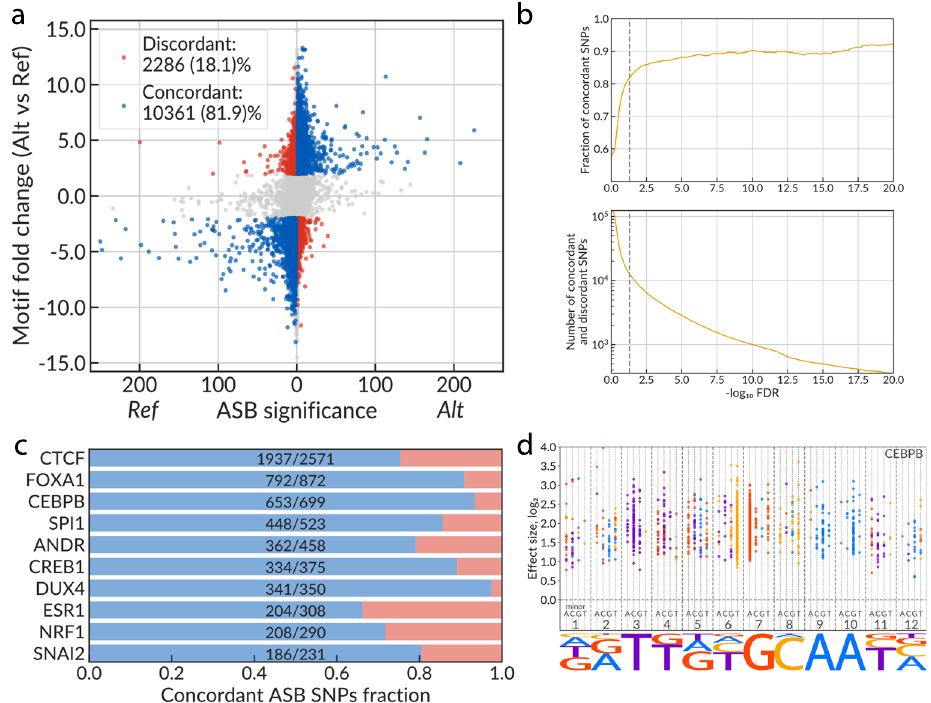
Fig. 4 Motif annotation of SNPs agrees with TF-ASB calls. a Scatterplot of the motif fold change (the predicted change in TF-binding af fi nity) vs the ASB signi fi cance for TFs that have PWMs in HOCOMOCO v11 core collection. The plot shows only the ASBs that overlap the TF motif occurrence (TF motif PWM hit with P value ≤ 0.0005). X -axis: signed ASB signi fi cance, the absolute value is max( − log 10 FDR Ref-ASB, − log 10 FDR Alt-ASB). The sign is set to negative if Ref-ASB is more signi fi cant than Alt-ASB (positive otherwise). Y -axis: motif fold change (FC) estimated as the log 2 -ratio of motif PWM hit P values between the reference and the alternative alleles (the positive value corresponds to a higher af fi nity to alternative allele). The SNPs are marked as concordant (discordant) and colored in blue (red) if they exhibit signi fi cant ASBs (FDR ≤ 0.05), have motif |FC| ≥ 2, and the preferred allele of the ASB corresponds to (is opposite to) that of the TF motif. ASB P values were estimated by logit aggregation of the one-tail Negative Binomial P values across the experiments (see “ Methods ” ) and then the FDRs were estimated with Benjamini – Hochberg procedure. b The total number of discordant and concordant SNPs and the fraction of concordant SNPs among them ( Y -axis) depending on the ASB signi fi cance cutoff, − log 10 FDR ( X -axis). c Barplot illustrating the proportion of SNVs with concordant and discordant ASBs for top 10 TFs with the largest total numbers of eligible SNVs. d The staveplot illustrating motif analysis of signi fi cant CEBPB ASBs. Each bead represents an SNV that is ASB and overlaps the predicted CEBPB binding site ( P value ≤ 0.0005) and has motif |fold change| ≥ 2. The X-coordinate shows the SNV position in the motif (underlined by the motif logo), the individual dashed strings denote four possible minor alleles at each position, the bead color is de fi ned by the major allele. The strand orientation of ASBs is aligned to the predicted motif hits. Y - axis shows the ASB effect size. SNP single-nucleotide polymorphism, ASB allele-speci fi c binding, PWM position weight